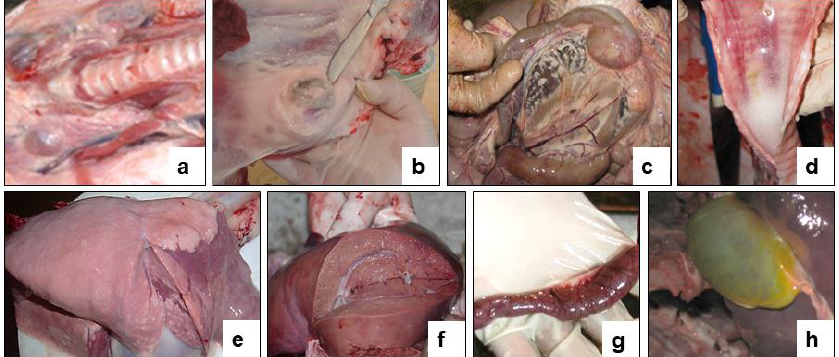
Figure 7. Internal examination of forcibly euthanized sheep post challenge with the field strain Kentau-7 of the PPRV. ( a ) Enlargement of the pharyngeal lymph nodes. ( b ) Enlargement of the pre-scapular lymph node. ( c ) Enlarged mesenteric lymph node on the incision. ( d ) Congestive hyperemia and isolated spot hemorrhages in the mucous membranes of the larynx and trachea. ( e ) Spotty hemorrhages under the serous membrane of the lungs. ( f ) Hemorrhages under the serous membrane of the liver. ( g ) The mucous membrane of the small intestine is swollen, reddened and covered with mucus (signs of acute catarrhal enteritis). ( h ) The gallbladder is full.